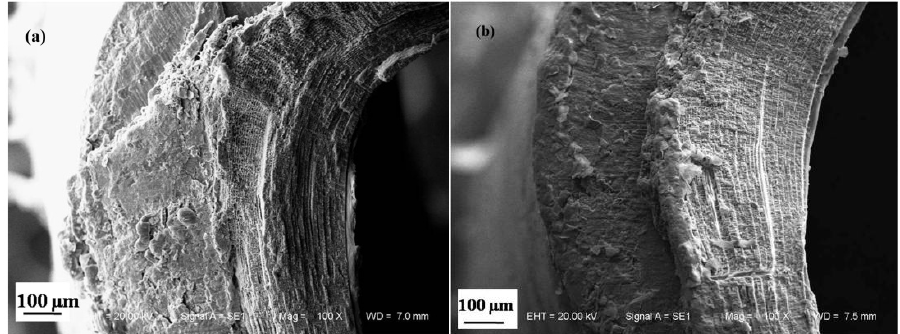
Figure 4. Thickness of the exocuticle and endocuticle at different positions along a Chinese mitten crab dactylopodite: ( a ) Section at l = 5 mm, ( b ) Section at l = 15 mm. For the same cross section, the thickness of the exocuticle and endocuticle changed with the concave–convex variation of the dactylopodite. Figures 3 and 4a show the microstructure of a cross